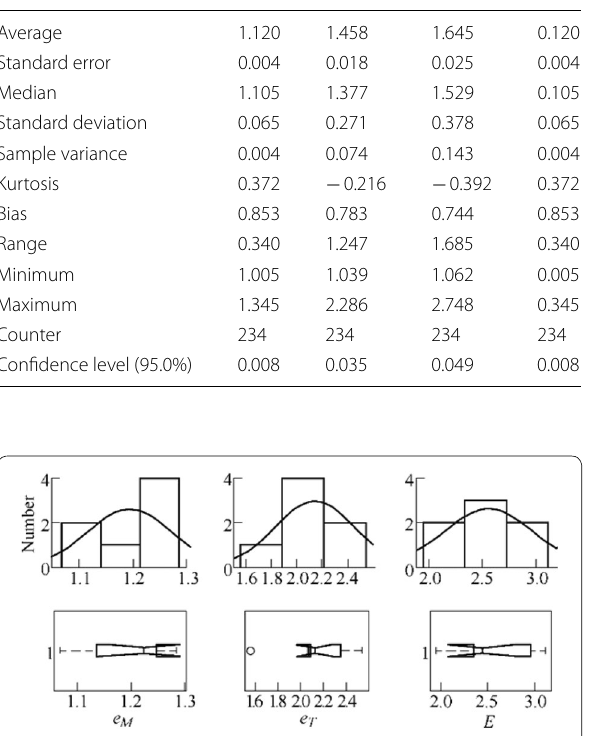
Figure 7 Histograms and box plots for fuel injected, turbocharged gasoline engines